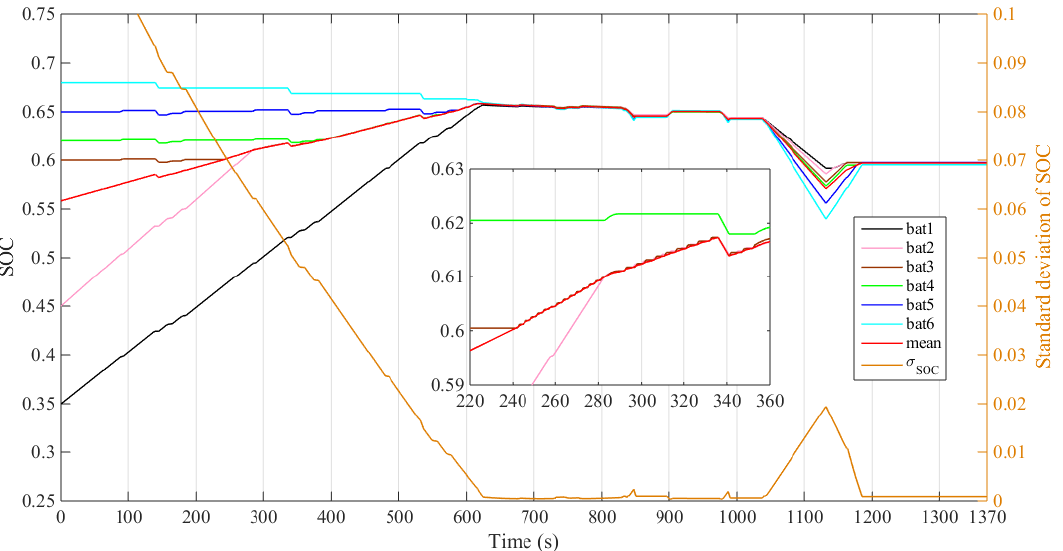
Figure 11. The SOC change of each battery. Energies 2020 , 13 , x FOR PEER REVIEW